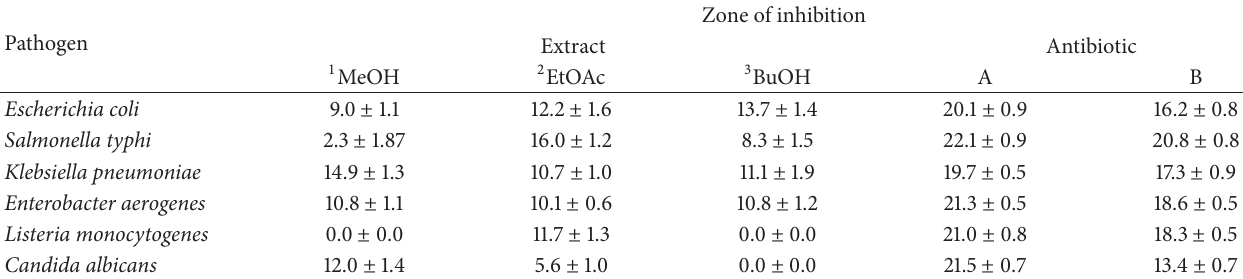
Table 1: Zone of inhibition of the different C. macrostachyus extracts against selected human pathogens.